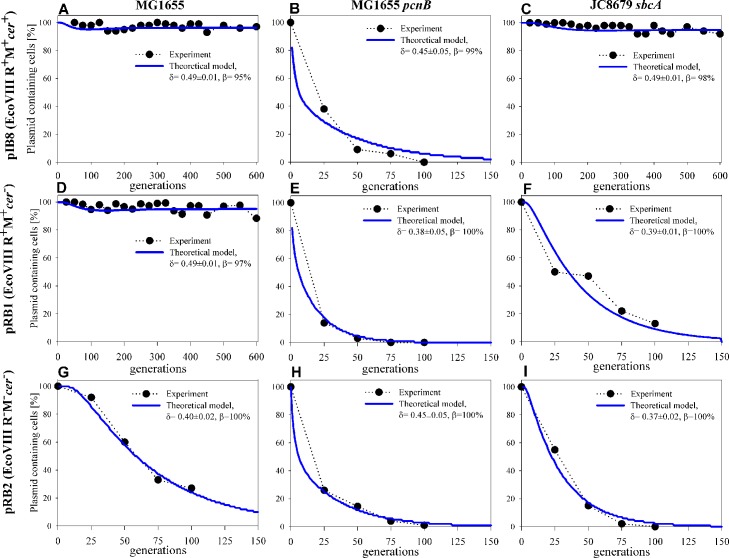
Comparison of experimental data obtained for pEC156-derivatives (pIB8, pRB1 and pRB2) maintenance in E. coli MG1655, MG1655 pcnB, and JC8679 sbcA with the theoretical model.Experimental points in panel B, E and H were taken from our previous report [35]. Thick lines are the best fit simulations for a given δ parameter.